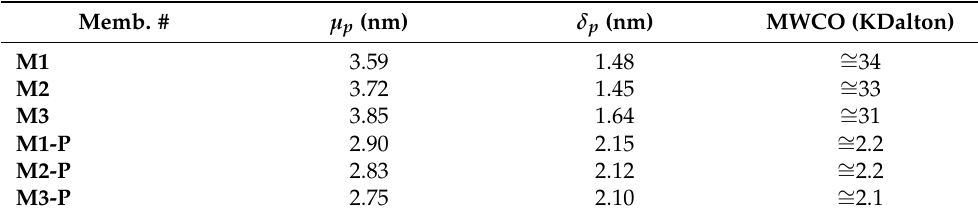
Figure 5. The MWCO profile of all formulated membranes (SD ± 3%). Table 4. The pore size ( µ ρ ), standard deviation ( δ ρ ), and MWCO profile of post-treated and non-post- treated